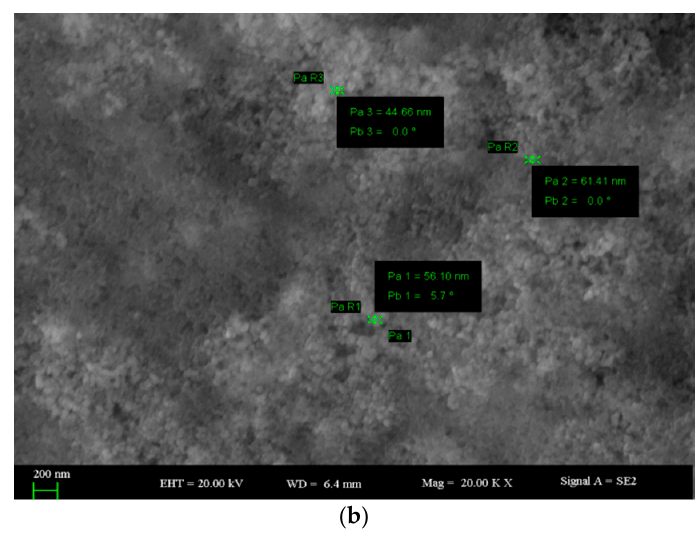
Figure 2 . ( a , b ) SEM images of AgCl-NPs.